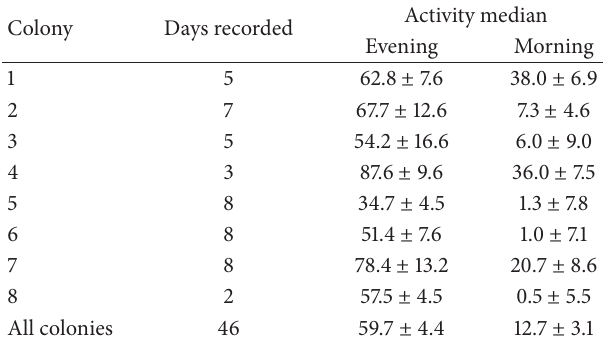
Table 1: Activity median (minutes ± SE) after sunset (evening) and before sunrise (morning) for eight colonies of Hyphantria cunea . Activity median Colony Days recorded Evening